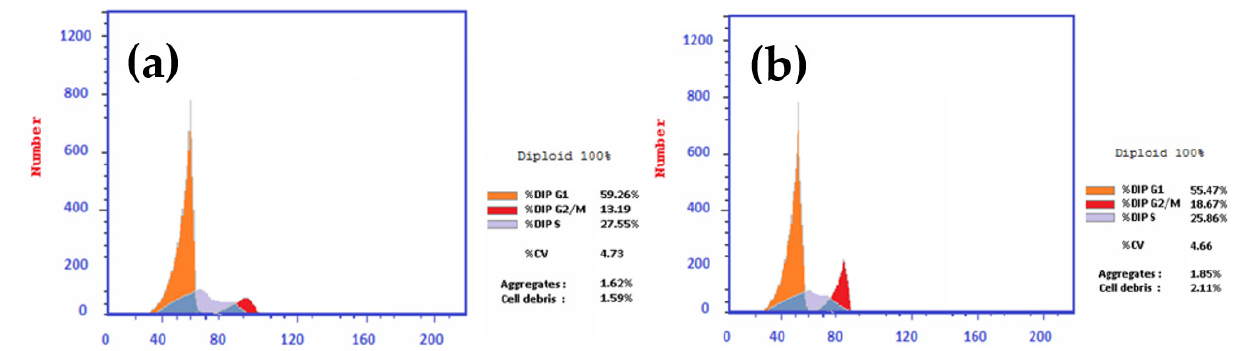
Figure 7. Cell cycle distribution histograms of ( a ) un-treated MCF-7 cells as control and ( b ) cells incubated with the mixture PIP-NMs/MTX-MNMs using IC 50 at 24 h.